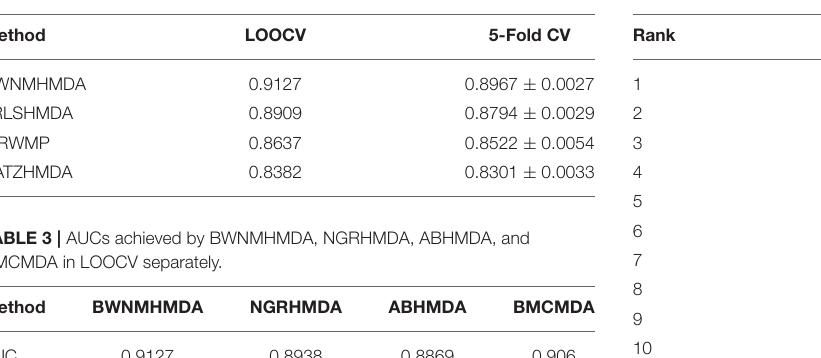
TABLE 4 | Top 10 potential asthma-related microbes predicted by BWNMHMDA and all of these 10 microbes have been confirmed by